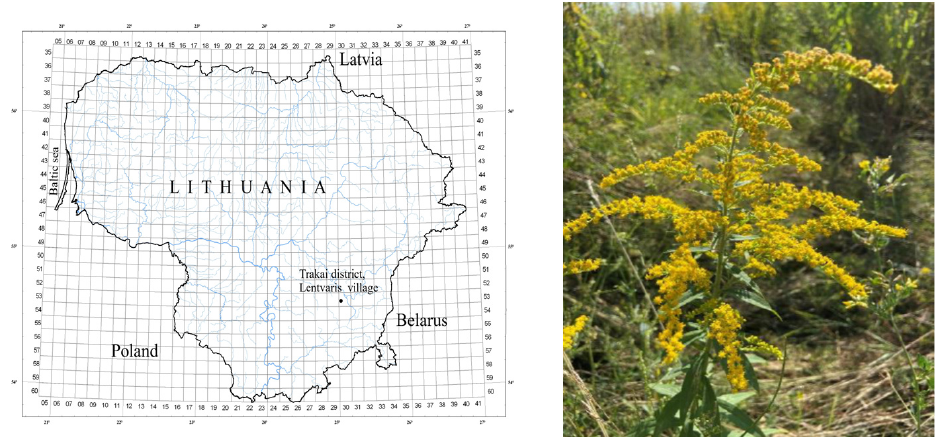
Figure 6. Geographical indication of sampling site in Eastern Lithuania (Vilnius, Trakai munici- pality, Lentvaris). Photo of S. canadensis (courtesy D. Stancelyt ė ) from the investigated